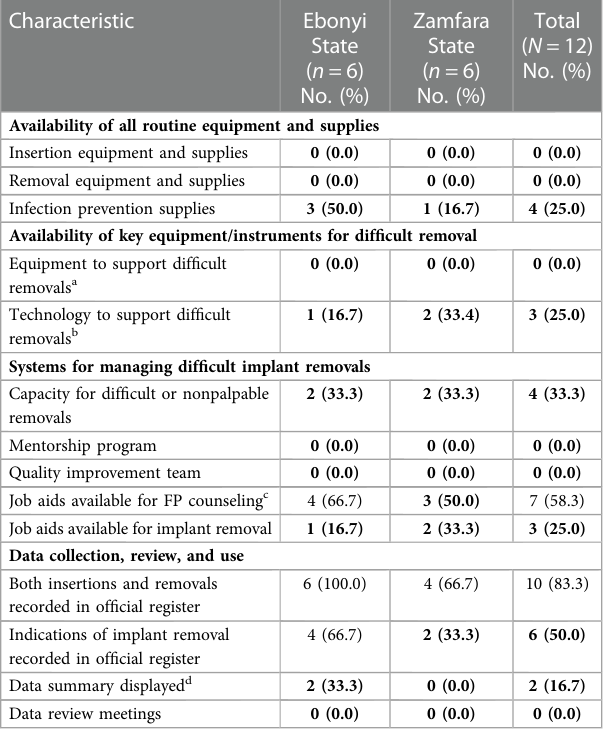
TABLE 3 Client-centered conditions related to implant insertions and removals at health facilities in Ebonyi and Zamfara States, Nigeria.